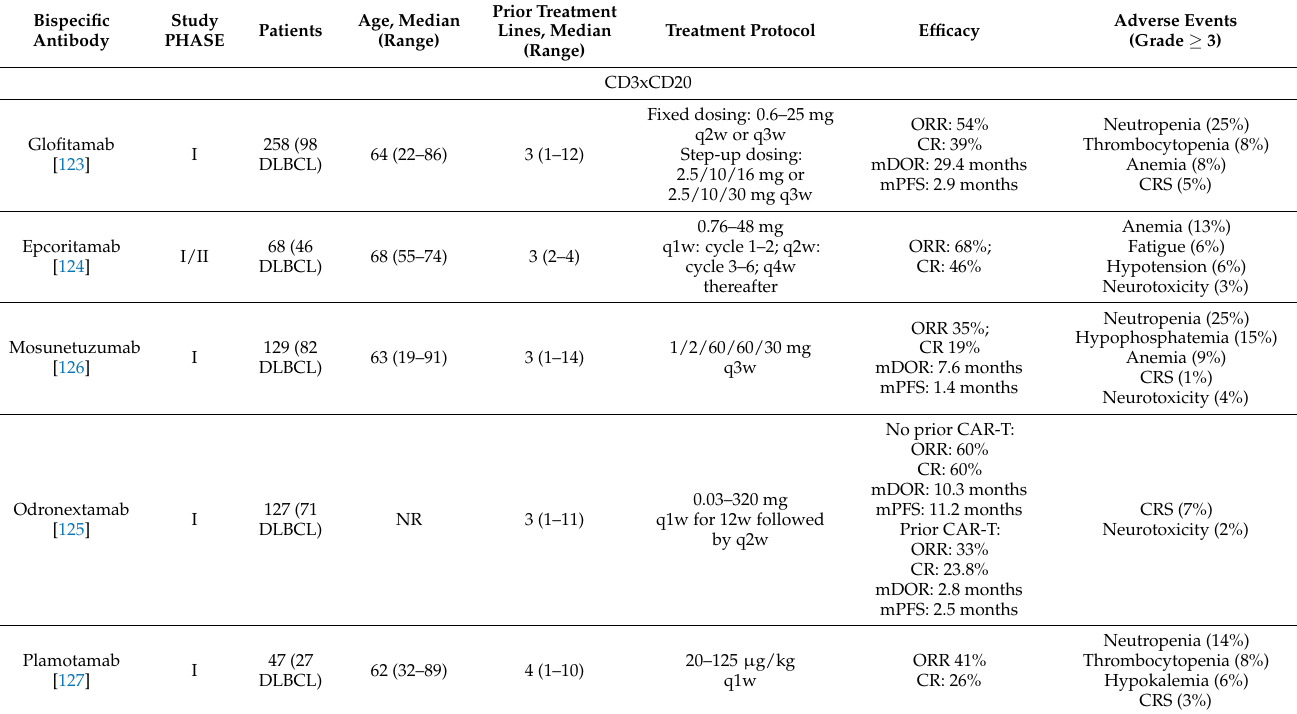
Table 7. Efficacy and safety of bispecific antibodies evaluated in clinical trials for the treatment of R/R